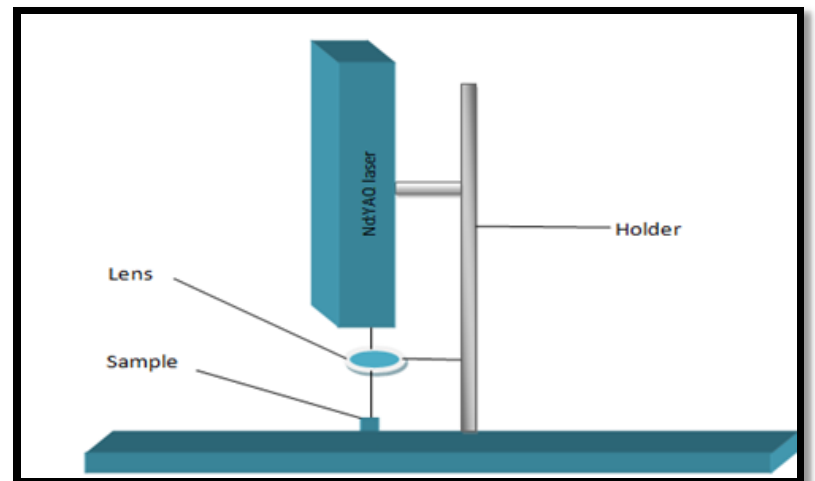
Fig.2: Experimental set-up used for